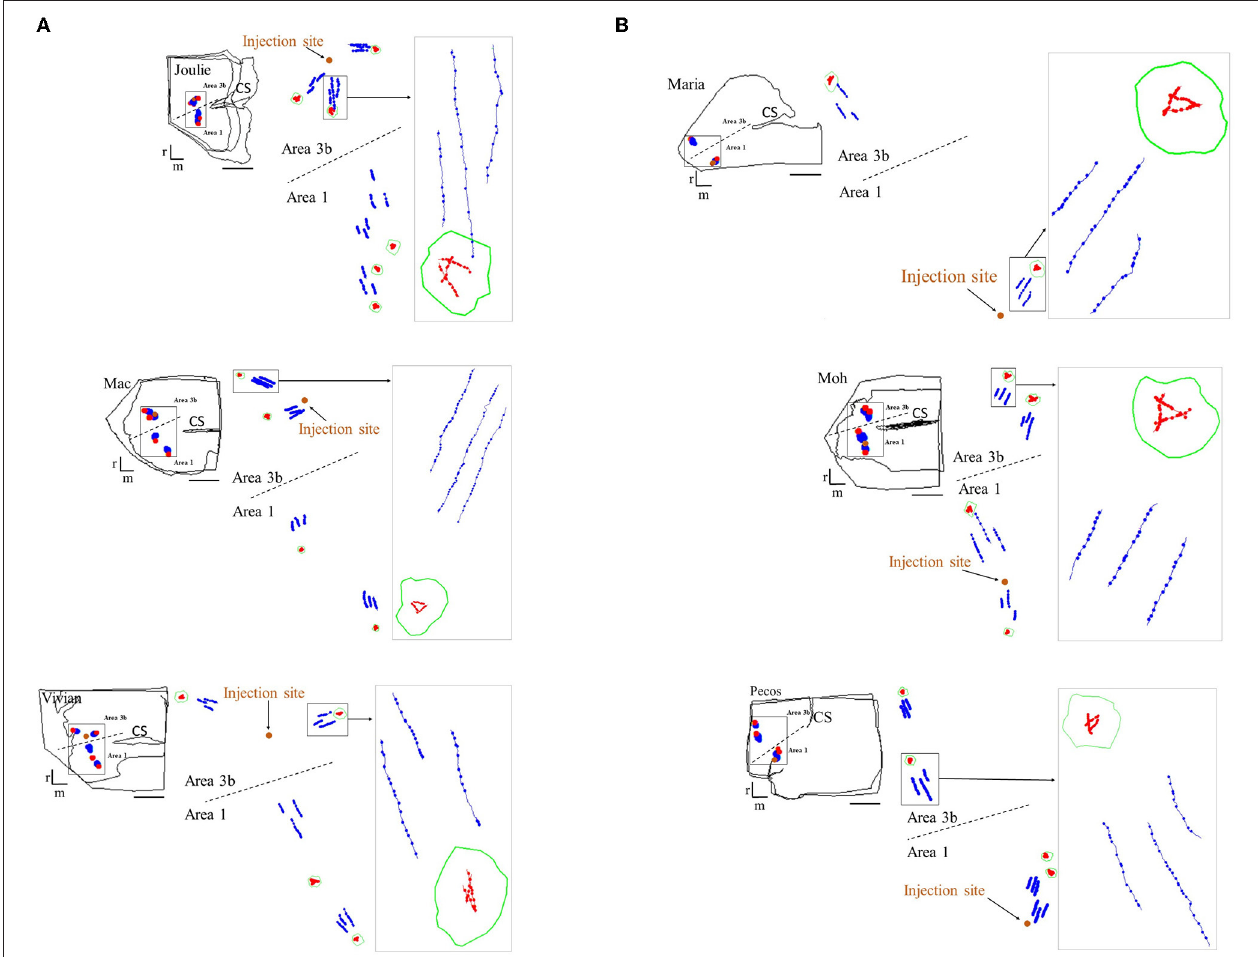
FIGURE 2 | Examples of reconstructions illustrating the morphology of patch and no-patch axonal segments in the six cases. (A) Area 3b injections and (B) area 1 injections. For each case: top left corner: miniature diagram of the section outlines including the reconstructed axons shown at higher magnification in the middle. Middle: enlarged view of the areas (demarcated by the rectangle in the section outlines on left) including the reconstructed axonal segments. The orange dot shows the location of the injection site. Right: high magnification view of the areas outlined by the rectangle (arrow). Note that, on the right, the high-resolution view is taken from a single section. Axon arborization patches are outlined by green contours. Patch axons and no-patch axons are shown in red and blue, respectively. Boutons formed by the reconstructed axons are marked with dots resulting in the beaded form of axonal segments. Examples include axons from both supragranular and infragranular layers, except for case M, where only supragranular axons can be reconstructed. Note the shorter length, highly variable direction and high bouton density of axons within the patch compared to no-patch axons. Dashed line represents the border between the two areas of the somatosensory cortex. r: rostral, m: medial. Scale bar: